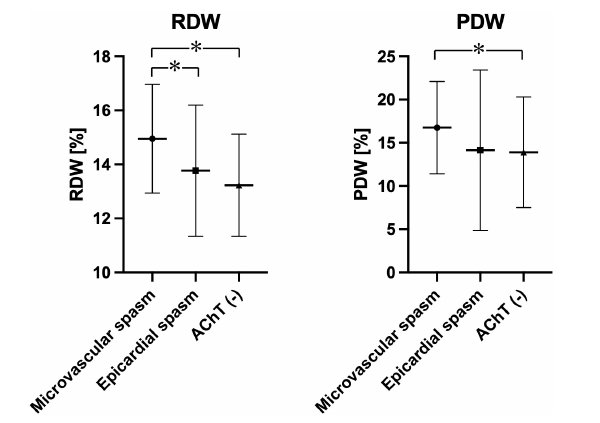
FIGURE 2 | Plots showing RDW and PDW in the study population depending on the AChT result. ∗ p < 0.05.